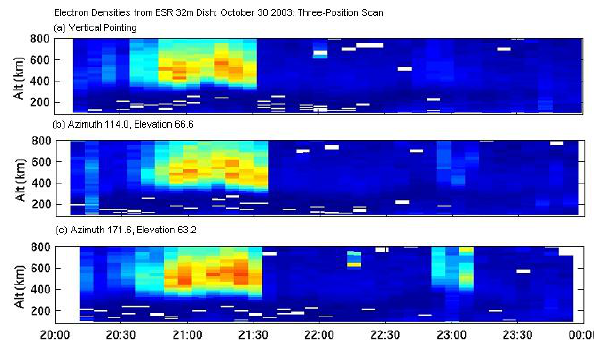
Fig. 9. Electron densities measured by the 32m dish ESR at (a) ver- tical pointing, (b) azimuth 114.0 ◦ and elevation 66.6 ◦ and (c) az- imuth 171.6 ◦ and elevation 63.2 ◦ between 20:00 and 24:00UT. The colour axes are the same as those in the upper panels of Figs. 1 and